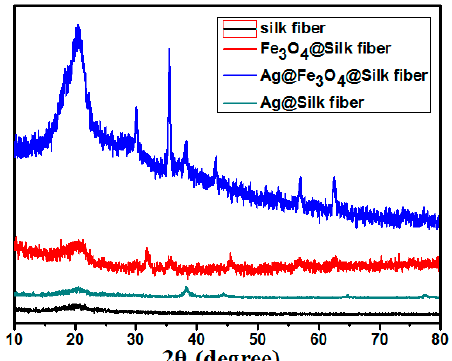
Figure 2. The X-ray diffraction (XRD) patterns of the silk fibers, Fe 3 O 4 –silk fibers, Ag–Fe 3 O 4 –silk fibers (2#) and Ag–Silk fibers.